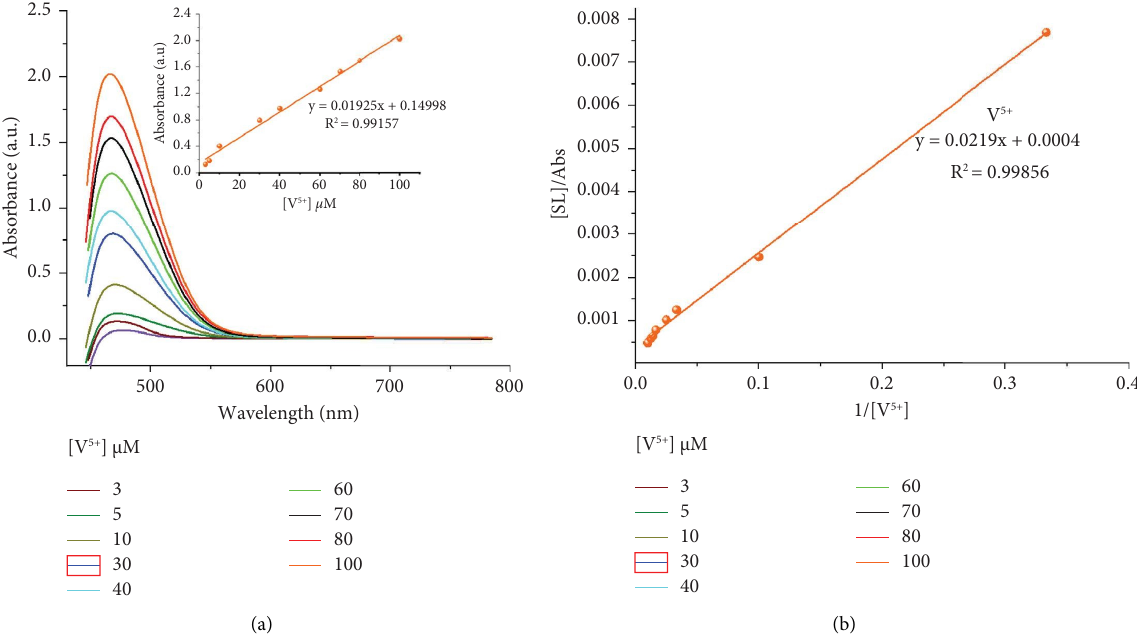
Figure 6: (a) UV–visible absorption spectra of SL upon the addition of diferent equiv. of V 5+ ions with absorbance intensity of SL as a function of V 5+ concentration at 470 nm (inset), and (b) Benesi–Hildebrand plot of [SL]/Abs against 1/[V 5+ ].